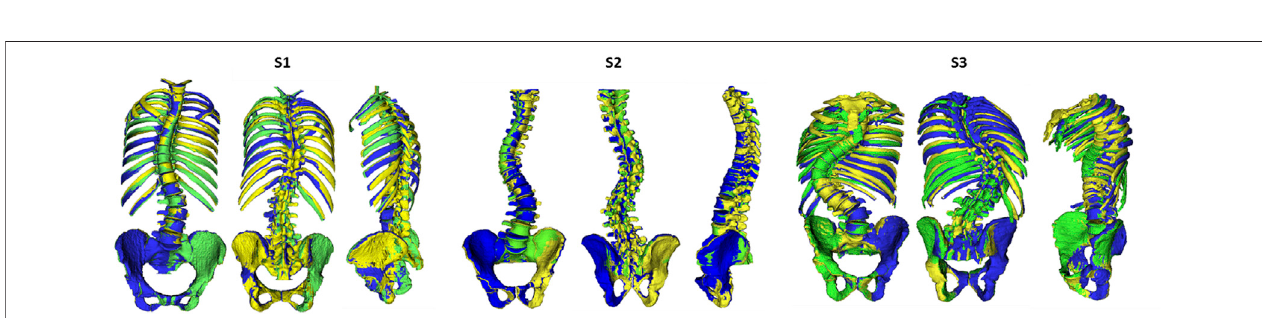
FIGURE 2 | Illustration of the alignment reconstruction for the three subjects [S1 (female), S2 (male) and S3 (male)] by the three operators: O1 (green), O2 (yellow) and O3 (blue).